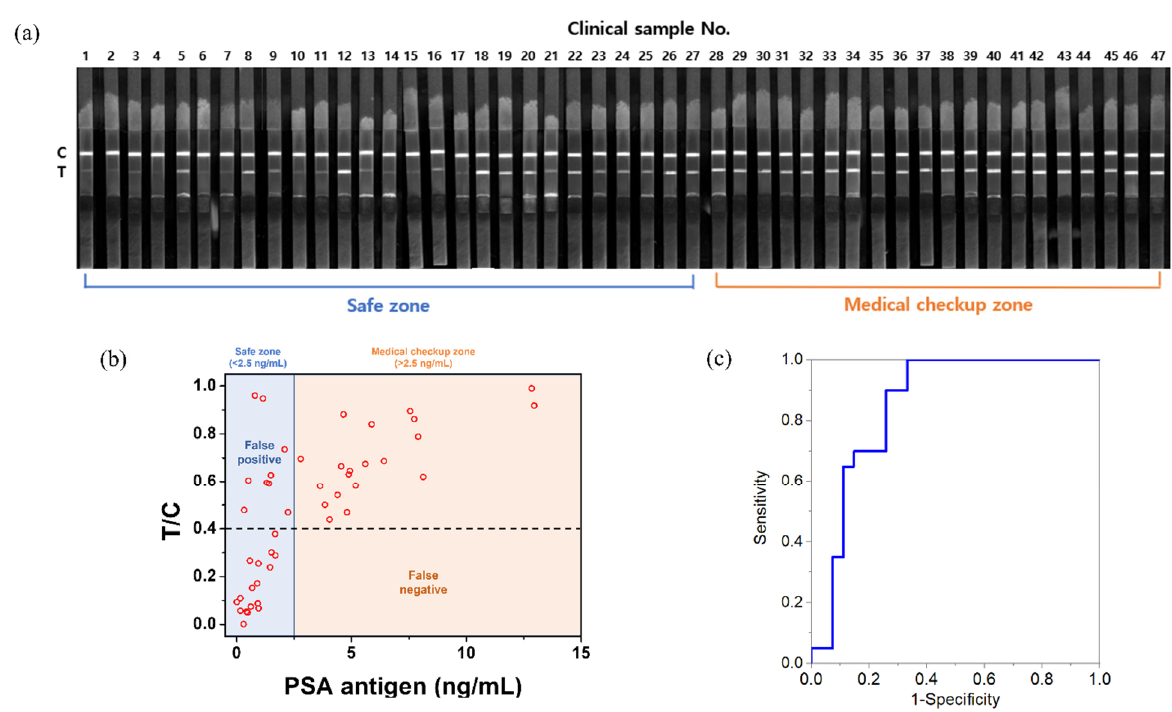
Figure 3. ( a ) Fluorescence image showing only the red channel of the test strip after the development of human serum samples under a 365 nm UV lamp; ( b ) T/C value and concentration of PSA of each human serum sample; ( c ) ROC curve. Table 1. PSA concentration in clinical samples.